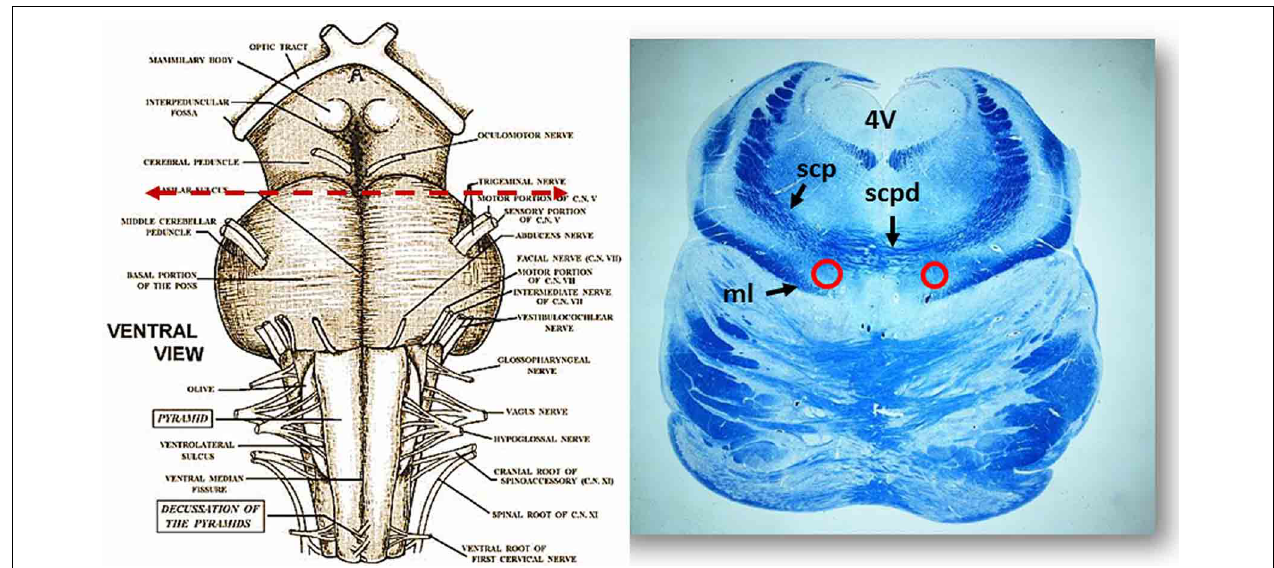
FIGURE 2 | On the left side the ventral brainstem surface scheme with the indication of the level of the histological section in the rostral pons, visible to the right. Circles show the bilateral localization of the Kölliker-Fuse